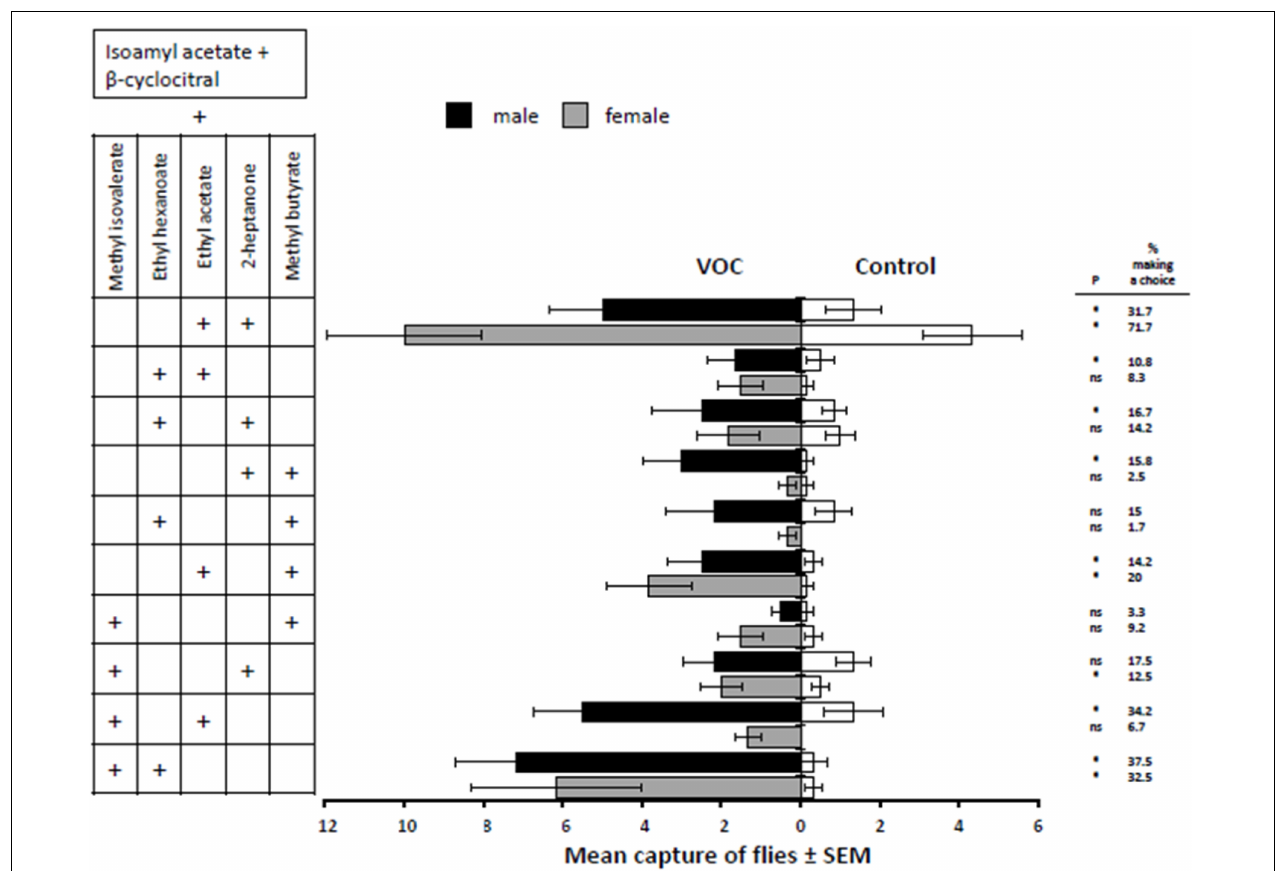
FIGURE 2 | Response of male and female D. suzukii to mixtures of two fruit volatiles added to isoamyl acetate and β -cyclocitral (VOC) against the mineral oil solvent (Control). P -values with ∗ indicate P < 0.05 and “ns” indicates a non-significant difference where P >